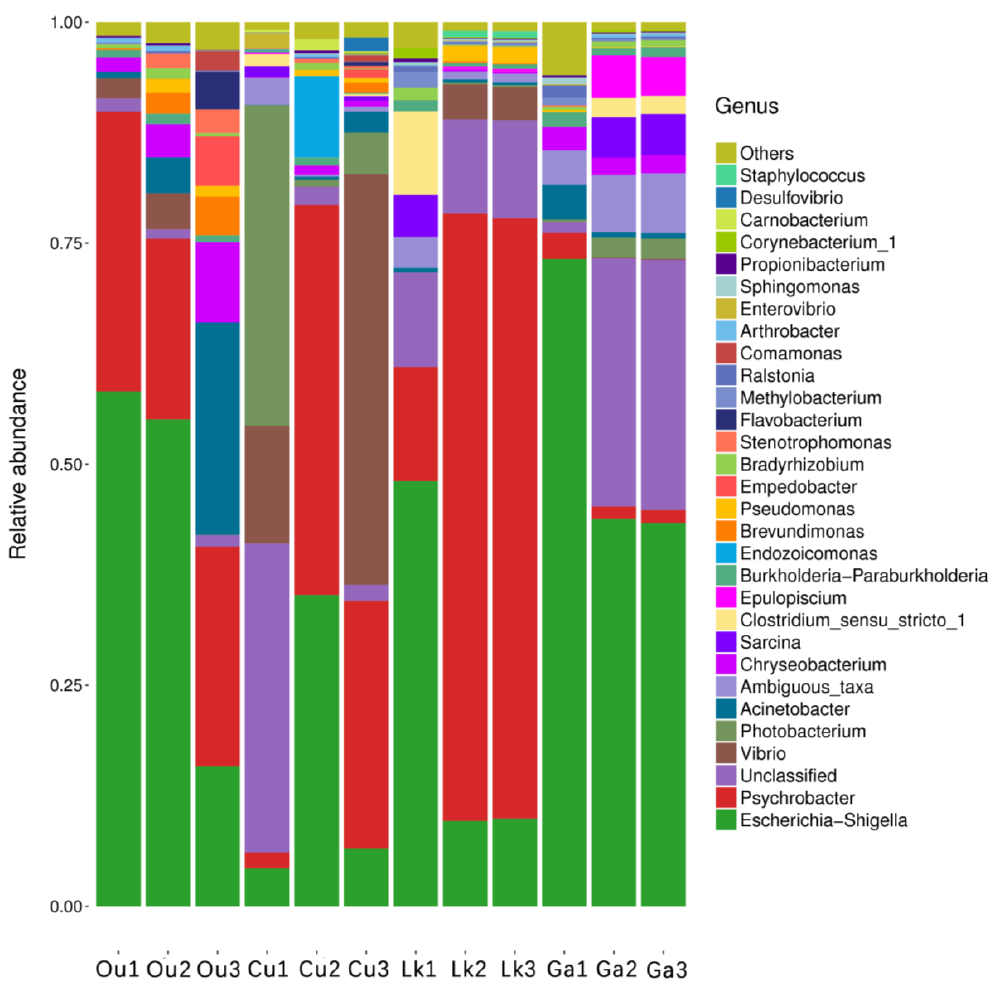
Figure 4. Interspecies gut microbial communities classified at the genus level. Ou: O. unifasciatus , Cu: C. urodeta , Lk: L. kasmira , Ga: G. aurolineatus.